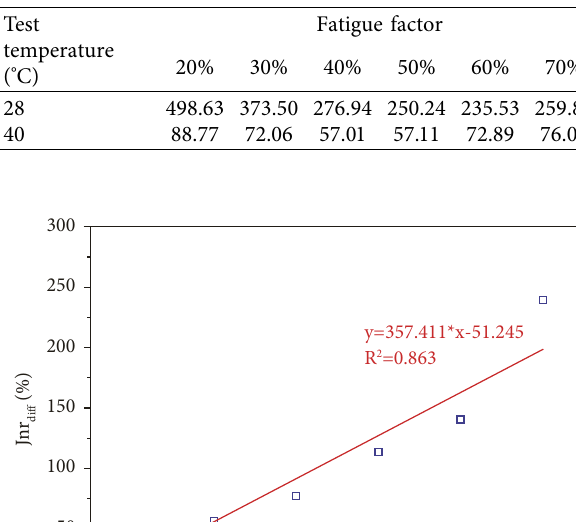
Figure 12: Effect of crumb rubber content on Jnr: (a) 0.1kPa and (b) 3.2kPa. Table 6: Fatigue factor test results of original asphalts.